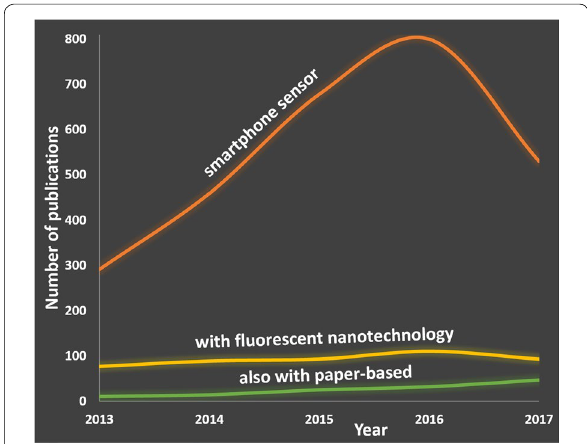
Fig. 1 The number of research article publications on smartphone sensor (orange), those with fluorescent nanotechnology (yellow), and above two with paper‑based fluorescent (light green) in the past 5 years. Web of science was